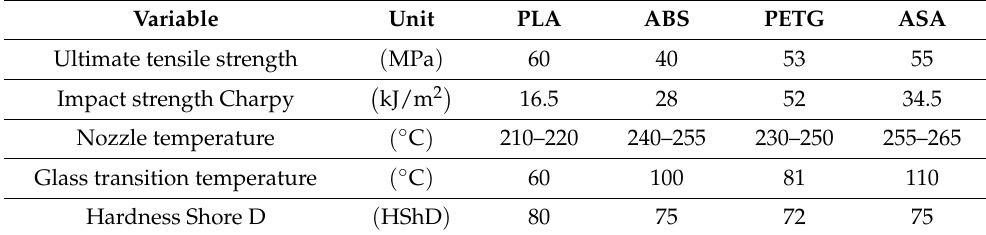
Table 2. Selected properties of applied additive materials